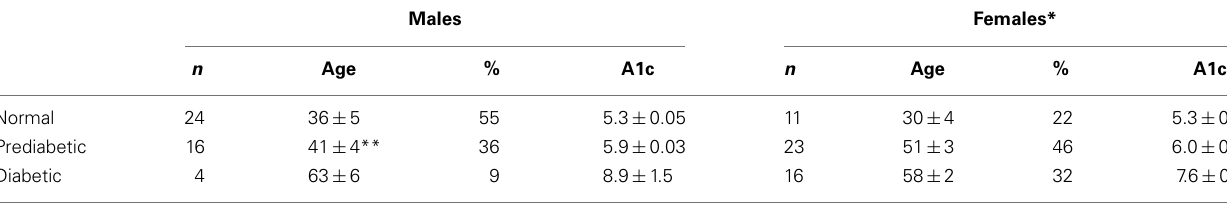
Table 2 | Gender differences in classification based on hemoglobinA1c levels .